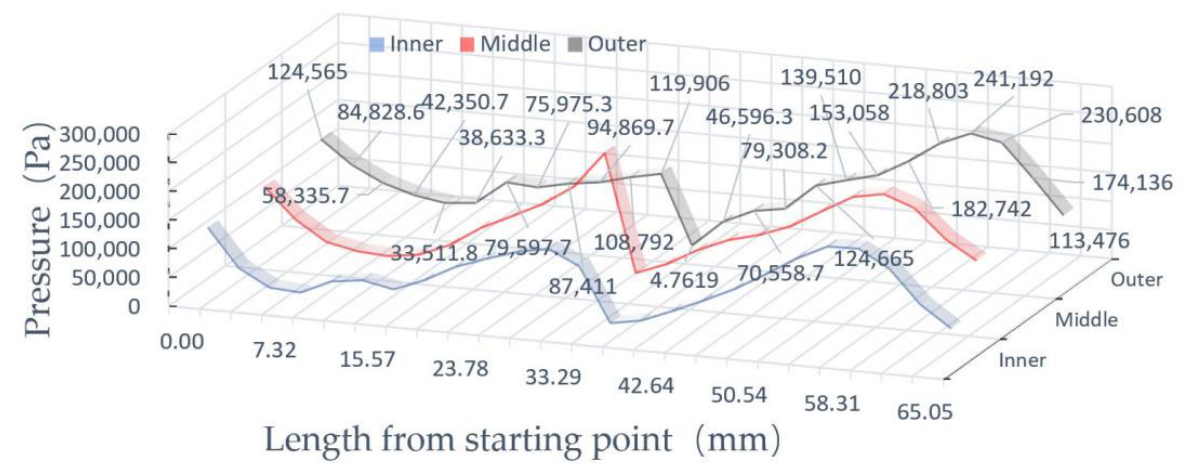
Figure 18. Pressure distribution of radial points inside the impeller.